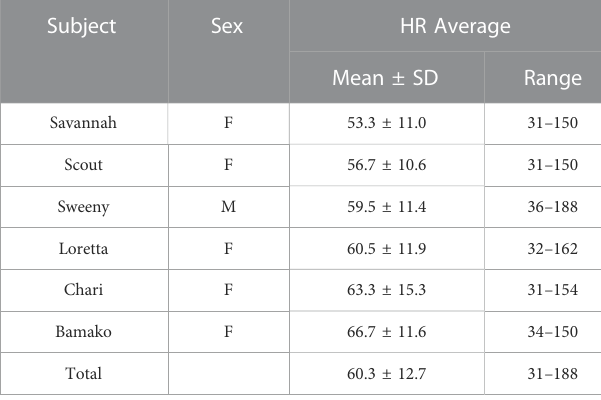
TABLE 3 Heart rate (HR) averages (bpm) for six captive scimitar-horned oryx. HR averages were continuously recorded at 2-min intervals for an average of 592 days per individual. Data for two study animals were removed because right sternal placement of the monitor reduced data